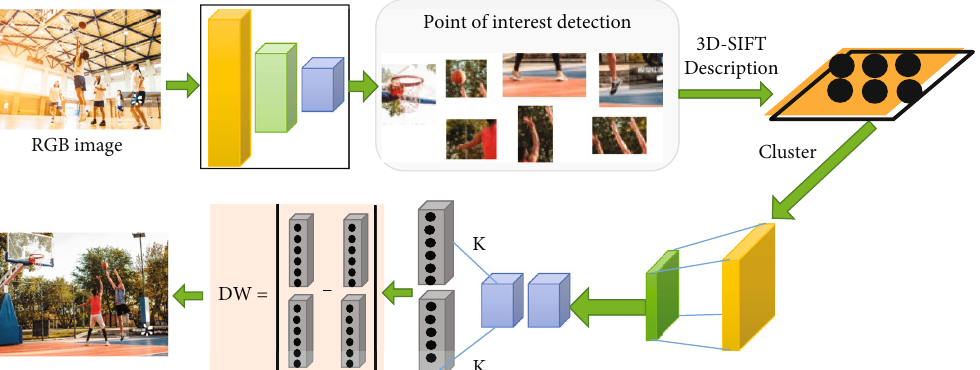
Figure 2: Generate a graphical representation of BOW